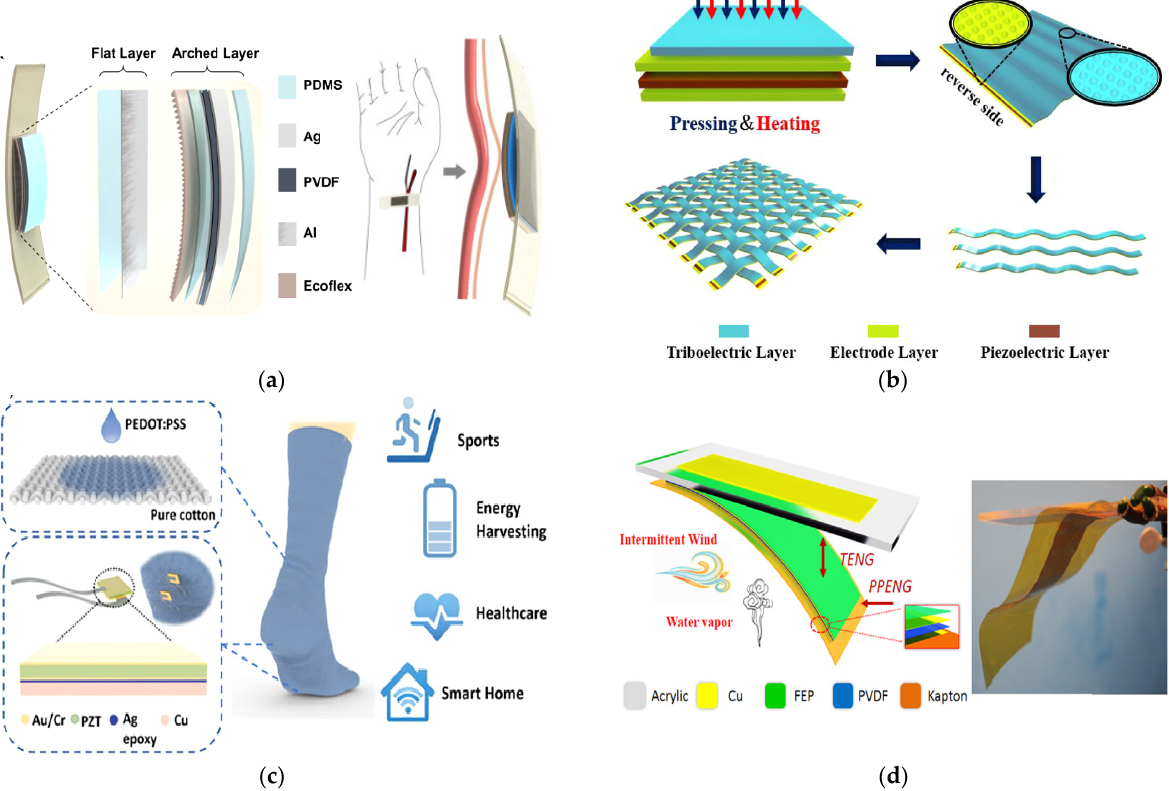
Figure 15. Examples of hybrid PTNG devices: Self-sustainable pulse sensors comprising self-arched PTNG to detect heart-pulse waveform [115] ( a ); flexible and elastic PTNG cloth with high output power, air permeability, and reliability for energy harvesting ( b ) [116]; self-sustainable and multi-functional socks combining TENG fabric and PZT micro-transducers [117] ( c ). PPENGs generate mechanical energy from the intermittent wind blowing either independently or concurrently and heat energy from water vapors ( d ) [118].